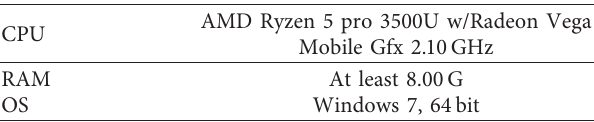
Table 15: Computer configuration for the calculation.